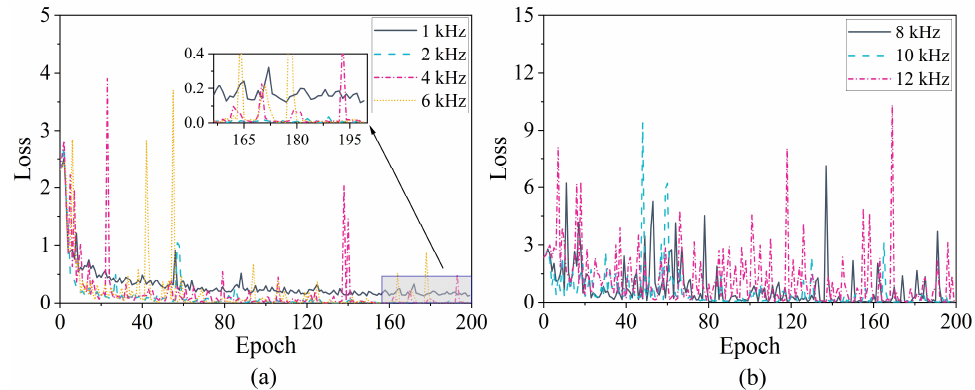
Figure 11. The validation loss of Dataset A ( a ) 1 kHz, 2 kHz, 4 kHz, and 6 kHz, ( b ) 8 kHz, 10 kHz, and 12 kHz.